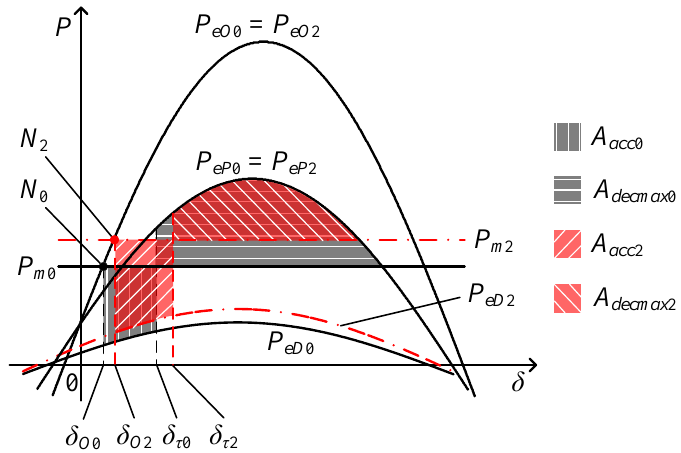
Figure 8. The comparison of the equivalent P -δ curves between the wind case operating in scenario two and the no-wind power case.